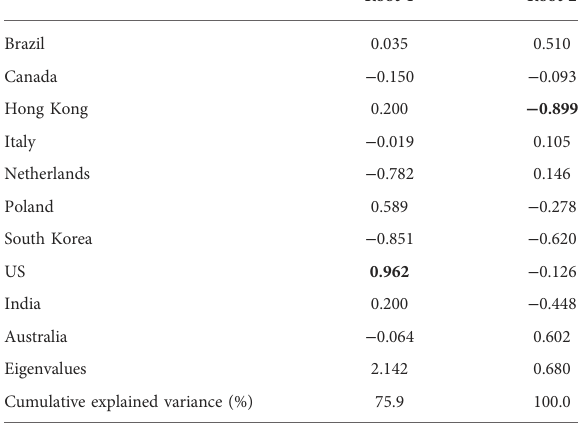
TABLE 3 Standardized coef fi cients of canonical